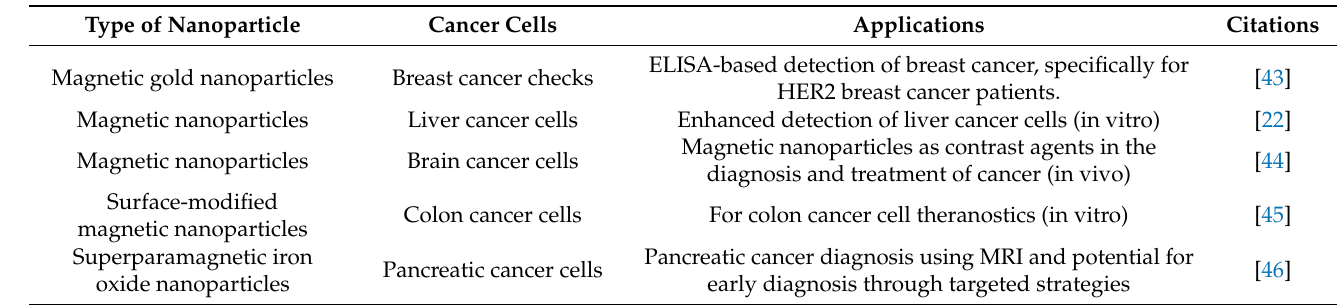
Table 5. Application of magnetic nanoparticles in cancer detection and screening.